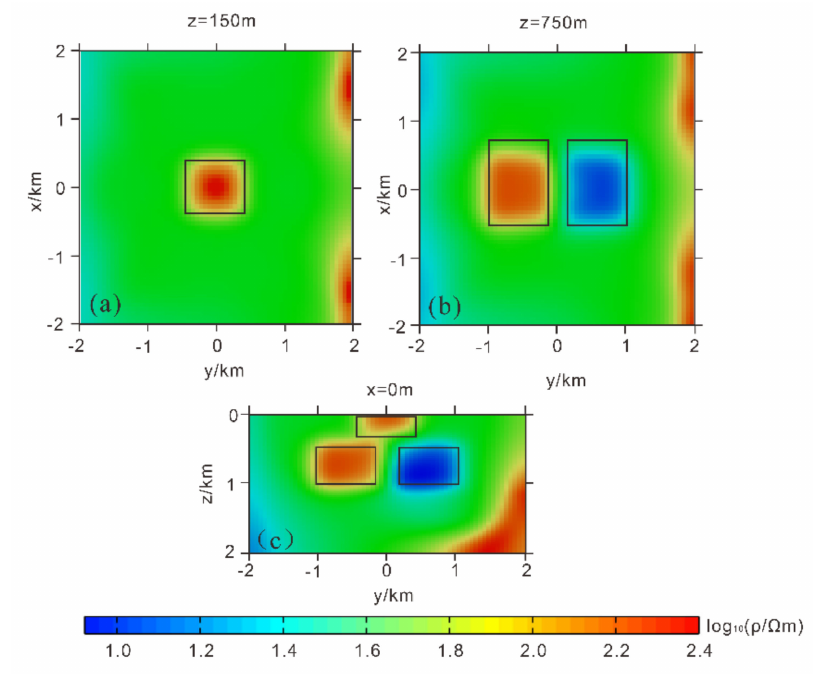
Figure 10. Inversion result yielded by the PSO-GD algorithm. ( a ) Horizontal sectional view at z = 150 m. ( b ) Horizontal sectional view at z = 750 m. ( c ) Vertical sectional view at x = 0